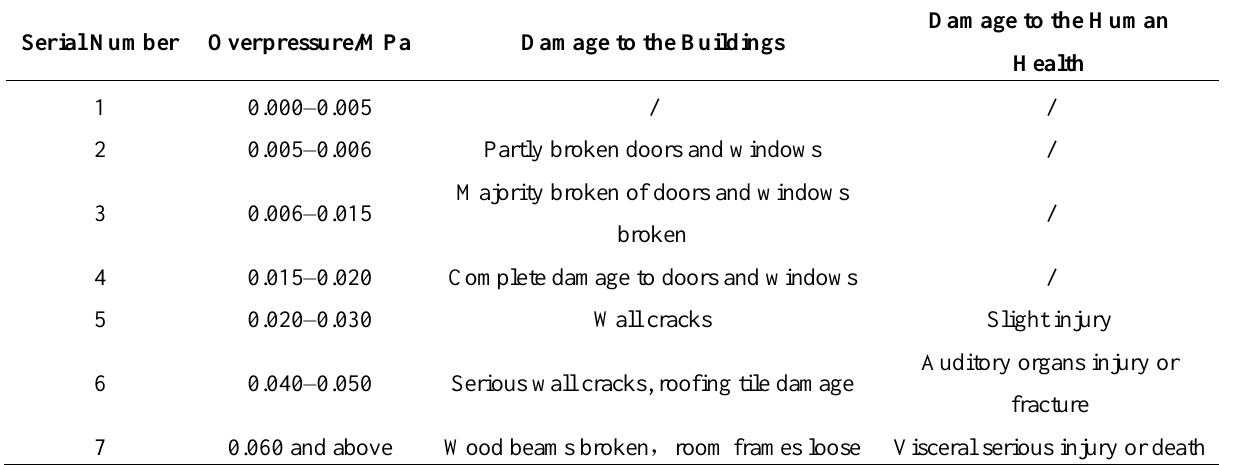
Table 4. Damage caused by shock waves to buildings and human health. The threshold values are adapted from a study by Fu et al. [32]. The symbol/denotes no influence is